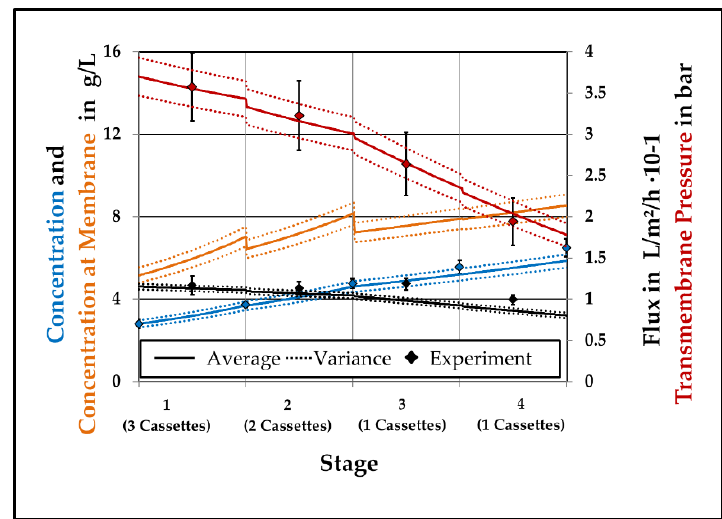
Figure 10. Profiles of concentration, flux and transmembrane pressure for modelled experiments of IgG in light phase.